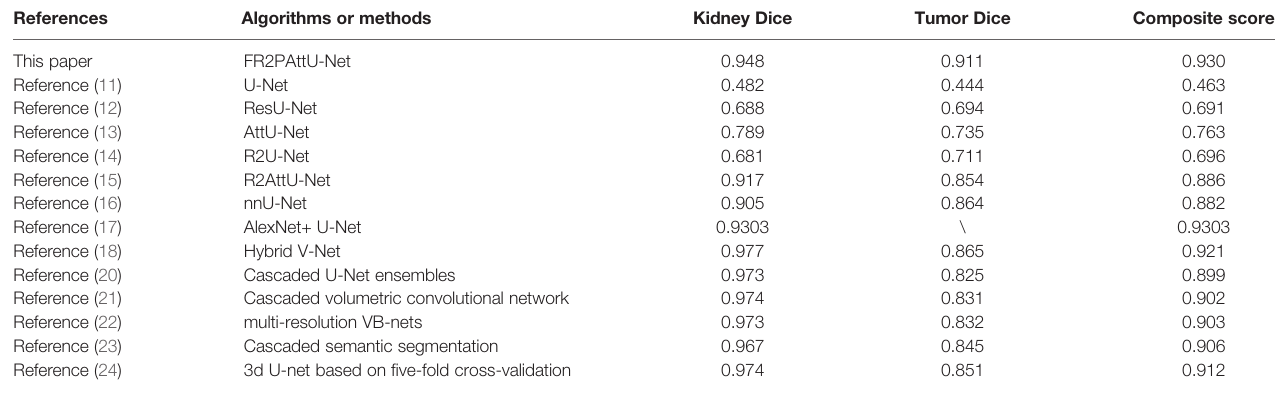
TABLE 5 | Segmentation results of several algorithms or